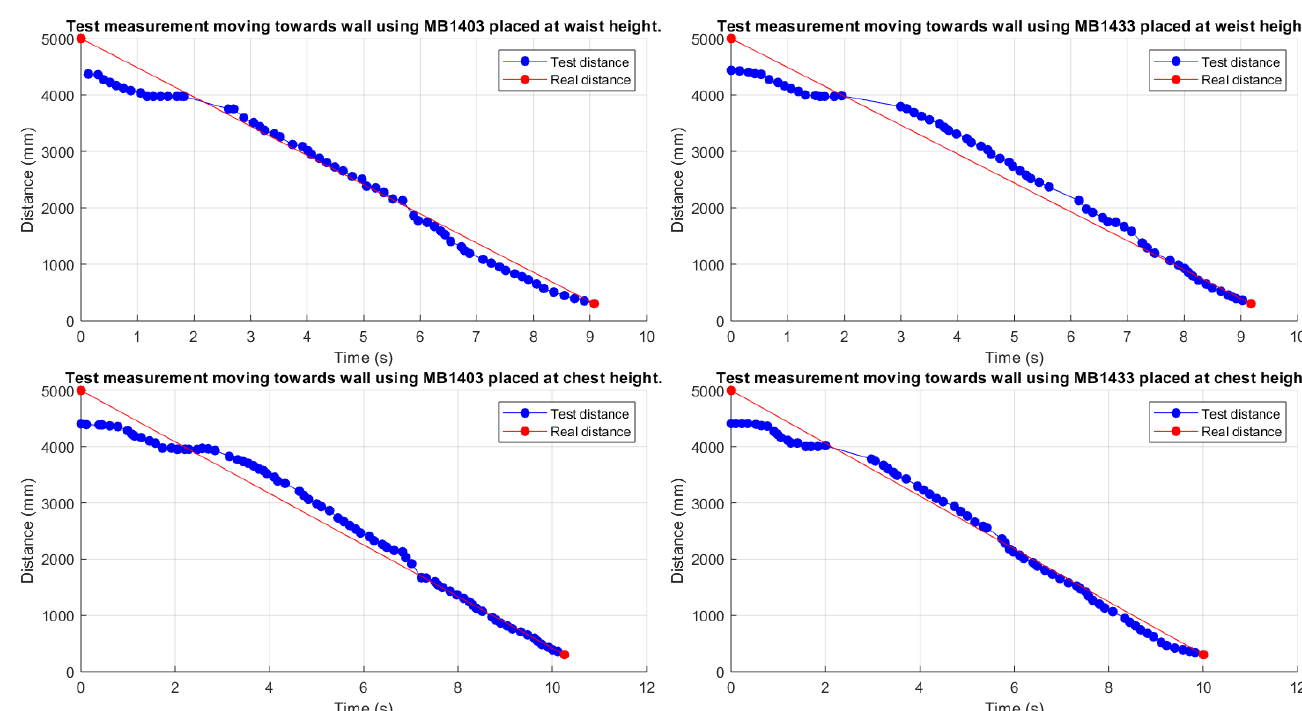
Figure 6. Distance estimates collected with a walk from a 5 m distance from the frontal wall towards the wall itself, wearing the IoT node at waist’s and chest’s